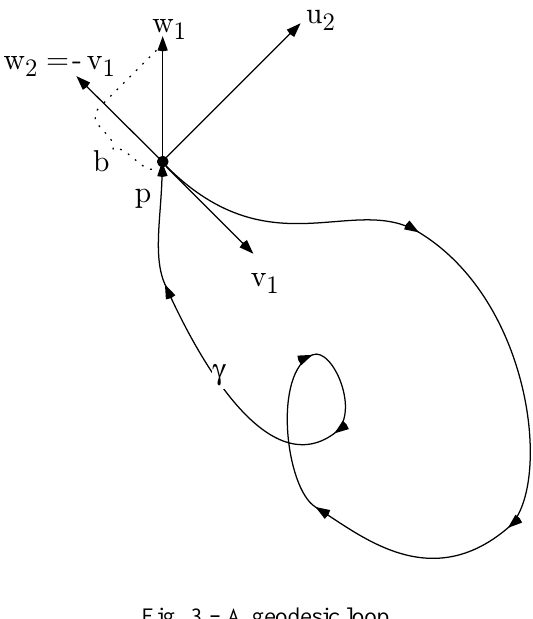
Fig. 3 – A geodesic